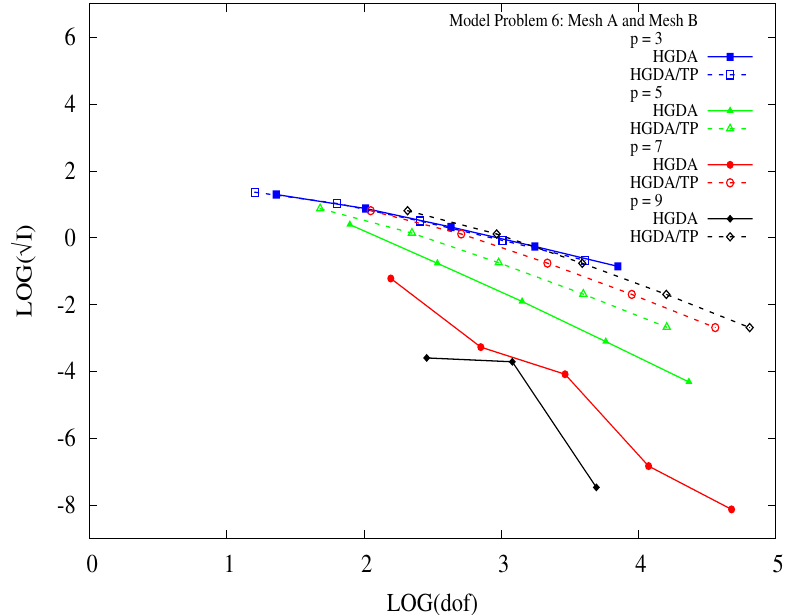
Figure 31. Residual function I versus dof, C 11 solutions: Model Problem 6 (Burgers Equation; Mesh B, HGDA/DG; Mesh A, HGDA/TP).